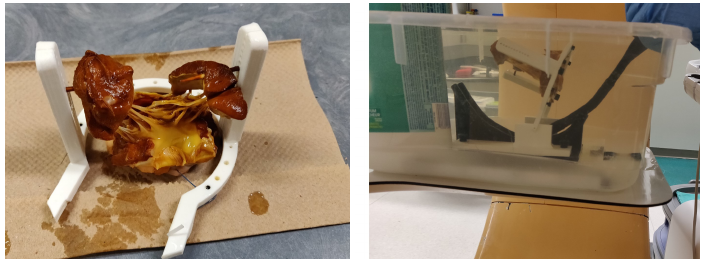
Figure 5. Excised porcine valve stained in iodine. Pictured on right is the valve being imaged using a TEE probe from a transgastric position.